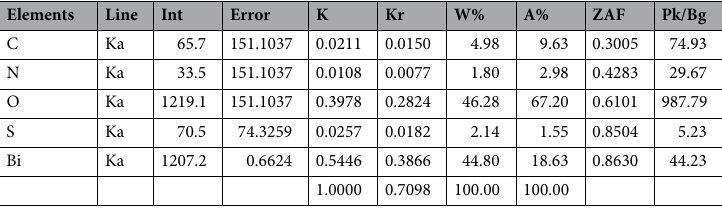
Table 2. Elemental composition results of Bi 2 O 3 /Gln-TSC NP in EDS-mapping